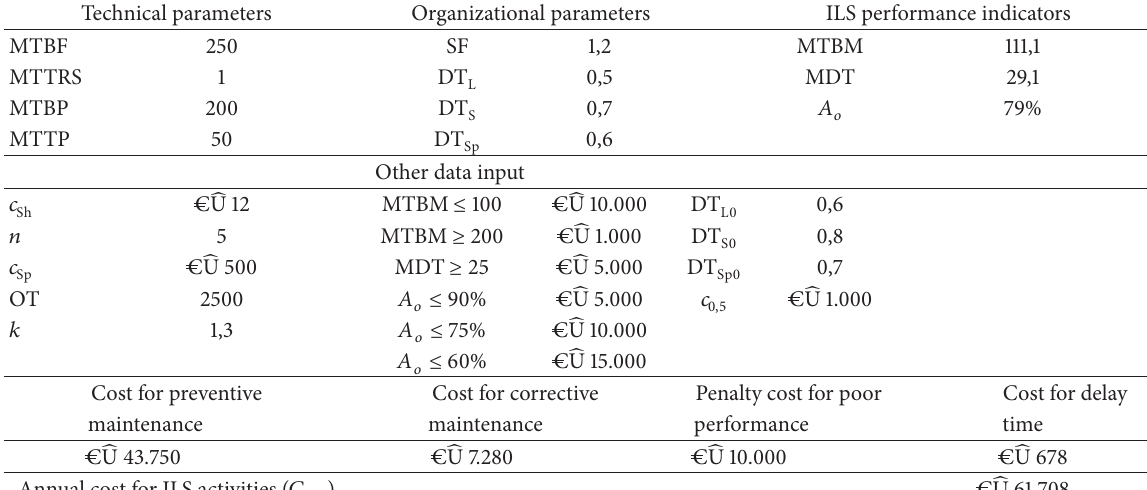
Table 5: Example of the cost model—basic